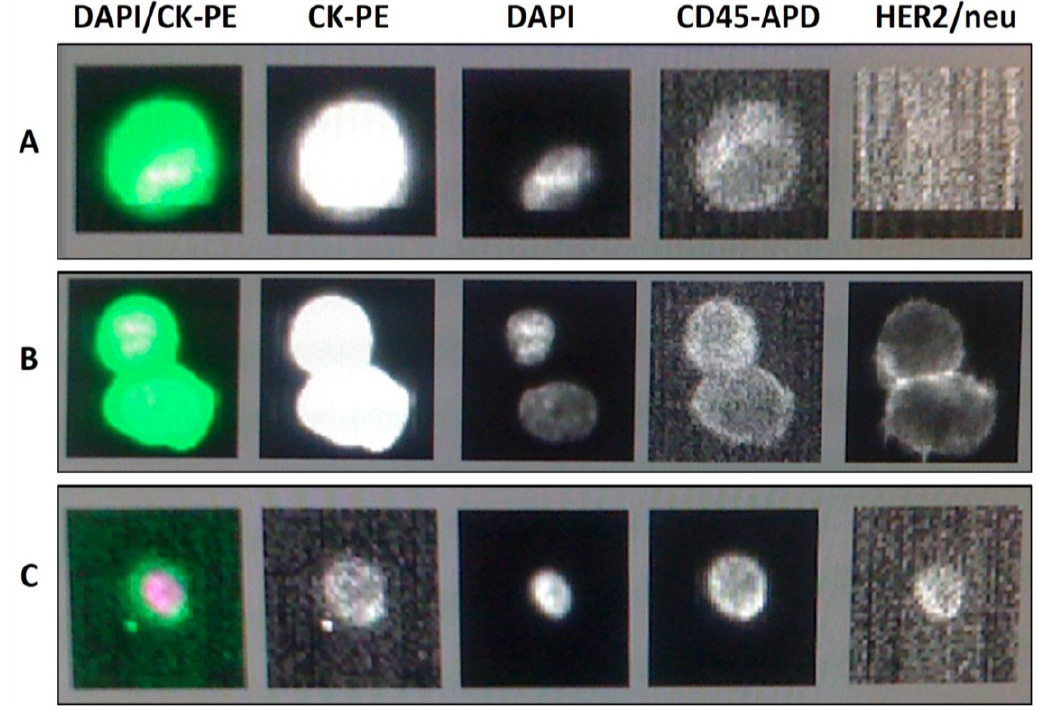
Figure 1. Typical appearance of isolated cells using the CellSearch ® method. DAPI: fluorescently stains nuclear material; CK-PE: detects presence of cytokeratin 8, 18, 19; CD45-APD: detects presence of CD45. ( a ) HER2 negative CTC : this cell is a CTC evidenced by CK positivity (2nd image from left) and DAPI positivity (3rd image) and CD45 negativity (4th image). HER2 immun(ofluorescence is negative (5th image); ( b ) HER2 positive CTC: CK is again positive, DAPI positive and CD45 negative consistent with this being a CTC. HER2 immunofluorescence is positive (5th image from left); ( c ) Lymphocyte : This cell is not a CTC as it is negative for CK (2nd image from left, compare with the two images above). DAPI positivity and CD45 positivity indicates this is a